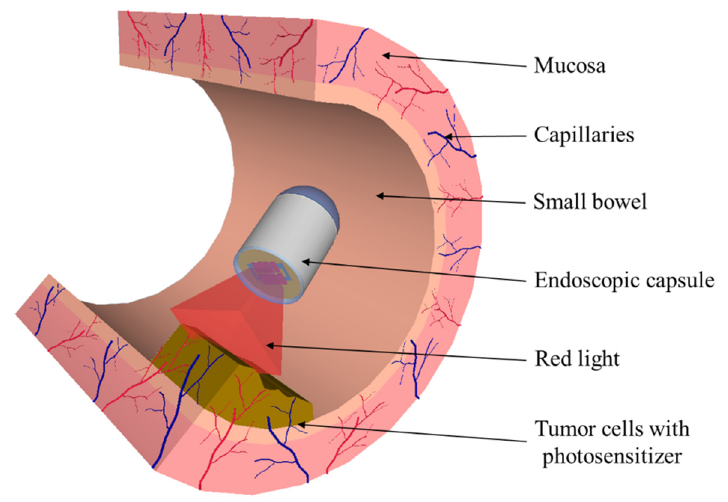
Figure 5. Illustration of PDT integrated in the endoscopic capsule (Adapted with permission from [83], IEEE, 2019).